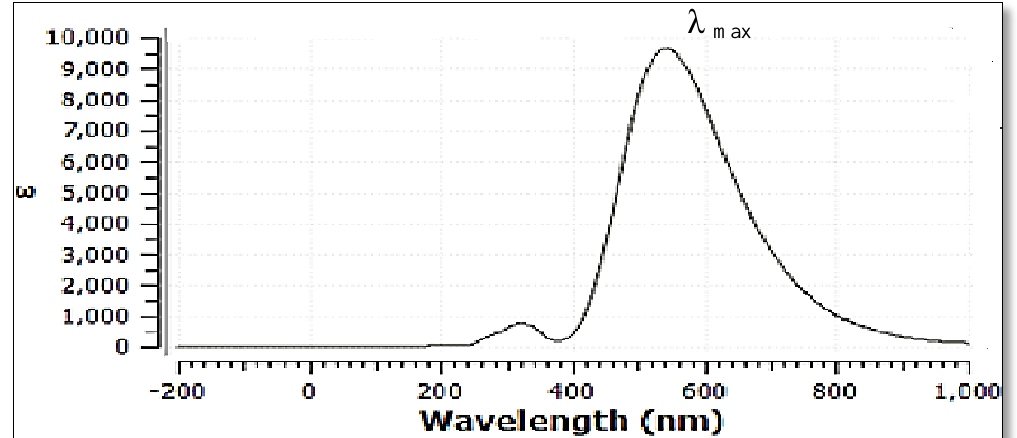
Fig.6: UV- visible spectrum of Iobengaune.